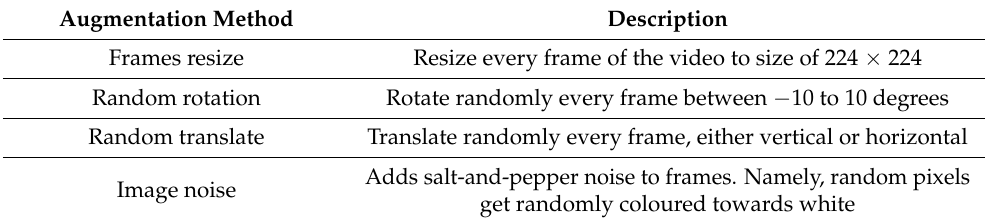
Table 2. Data augmentation methods adopted in this work.